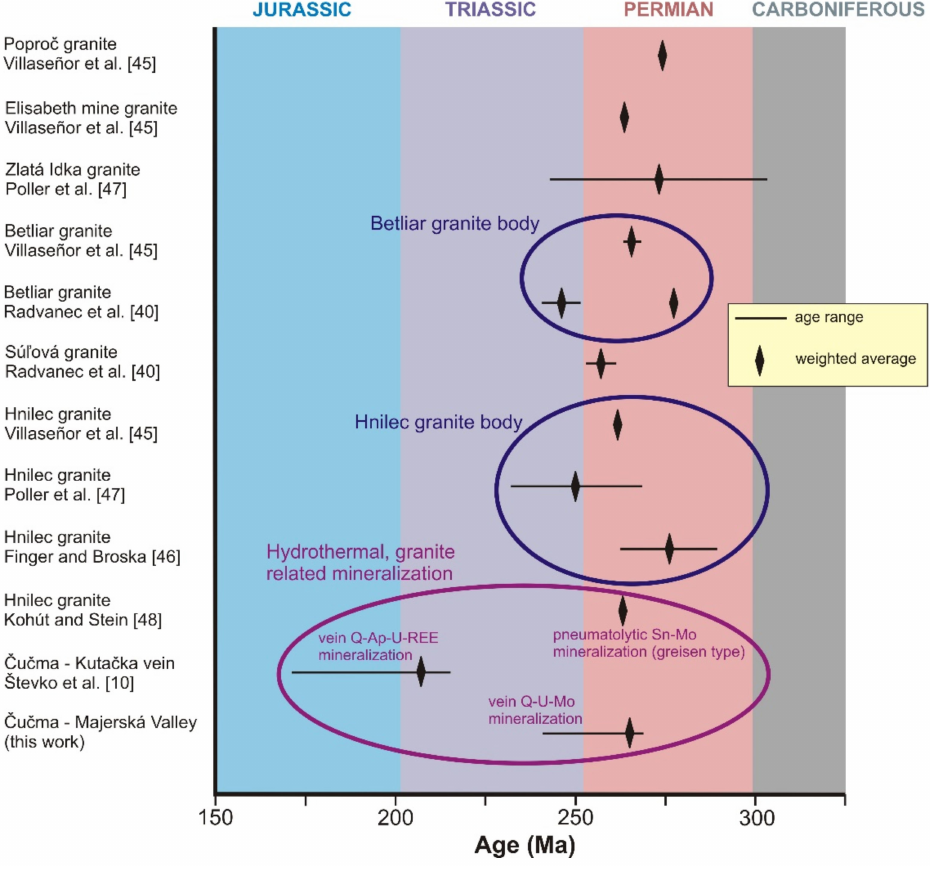
Figure 14. Summary of the age data of the Gemeric granites and associated hydrothermal mineral- ization. The age boundaries of the stratigraphic periods are plotted according to the ICS